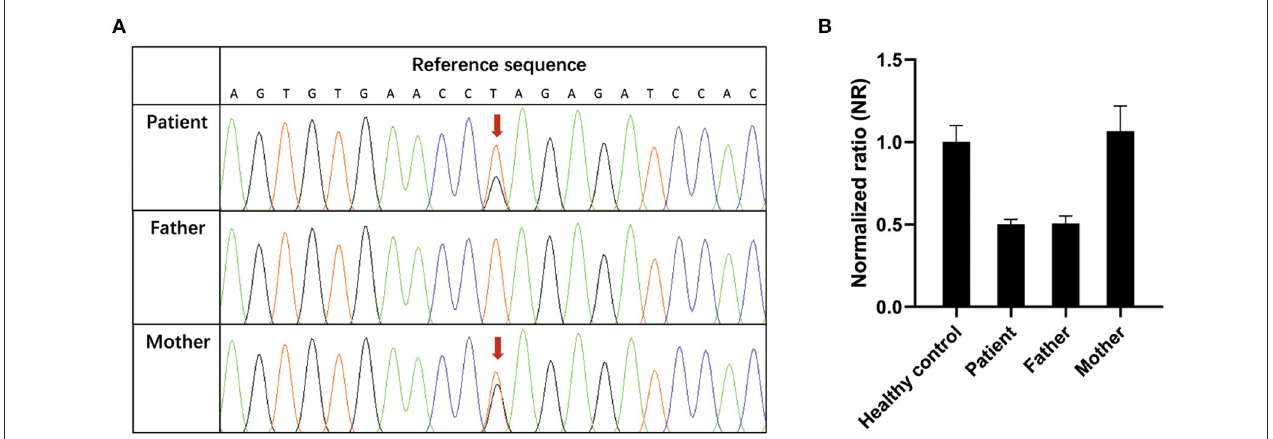
FIGURE 1 | Confirmation of novel IL-10RA variants. (A) c.395T > G variant (red arrow) confirmed by Sanger sequencing. (B) Validation of the ex.1del (p.?) variant by quantitative PCR. Genomic DNA was extracted from peripheral blood from the patient, her parents and healthy controls. Reactions were set up using one set of primers upstream and downstream of exon 1 in triplicate. The β -actin gene served as a reference gene. The 2 − 11 CT method was used to calculate the copy number. Samples with normalized ratios (NRs) < 0.1 denote individuals with homozygous deletion, samples with NRs of about 0.5 denote individuals with heterozygous deletion, sample with NRs of ∼ 1 denote healthy individuals (two copies), and samples with NRs of ∼ 1.5 or more denote individuals with copy number gain.